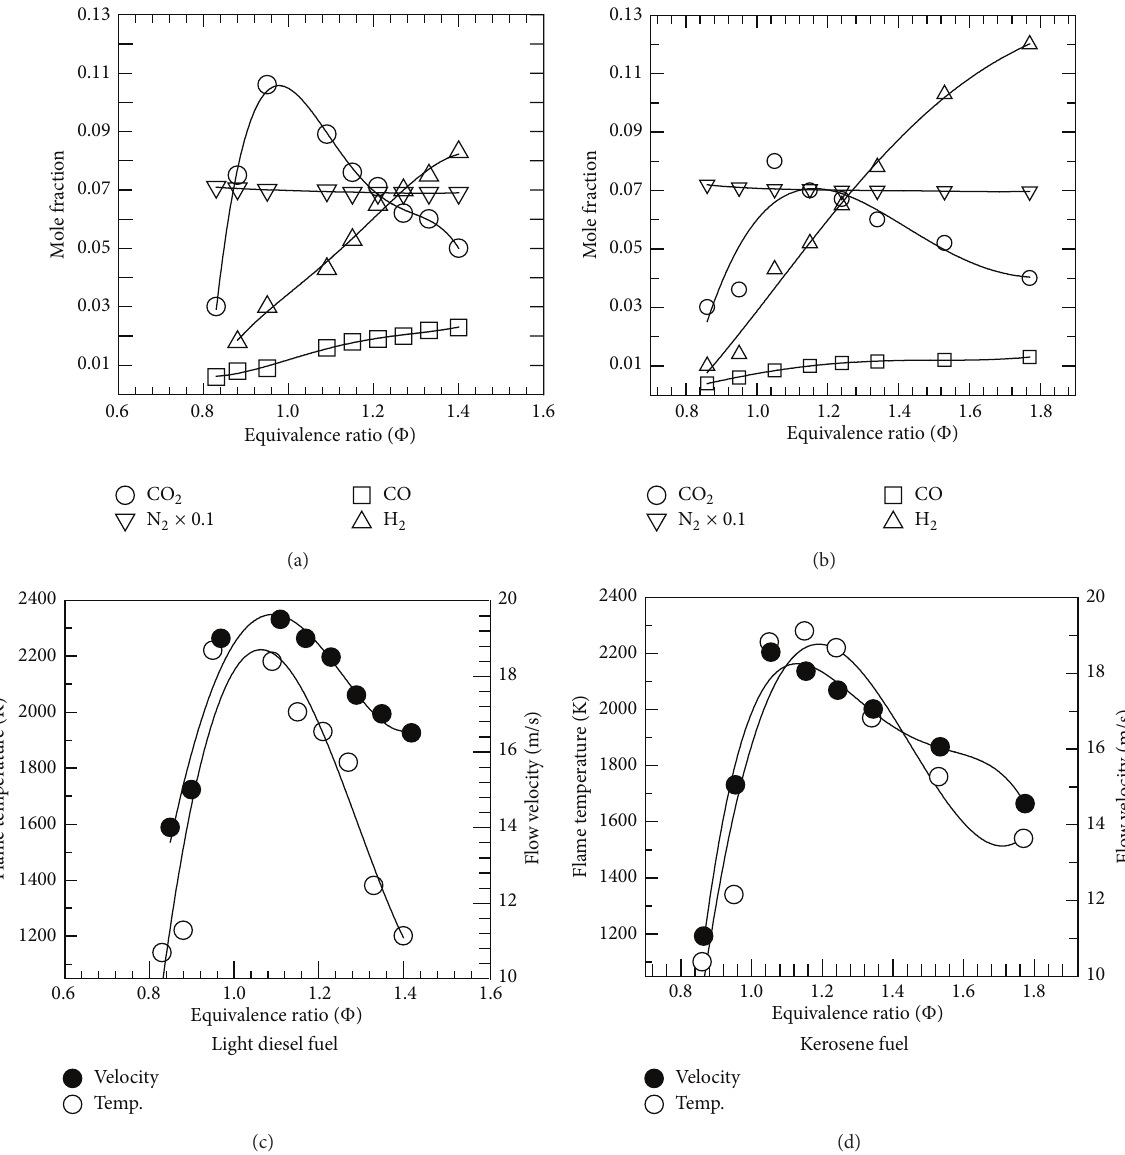
Figure 7: Effect of equivalence ratio on flame structure for turbulent premixed-air flame at residence time 5.4 ms, Reynolds number 11.08 × 10 3 , solidity ratio 0.68, and pressure